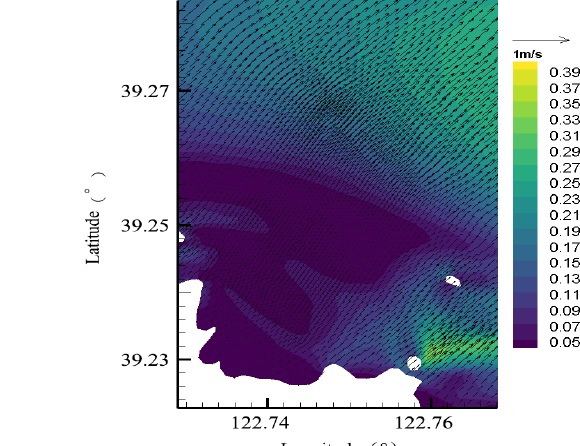
Figure 12. Residual current distribution in the sea area near the aquaculture area ( left : before aquaculture; right : after aquaculture).